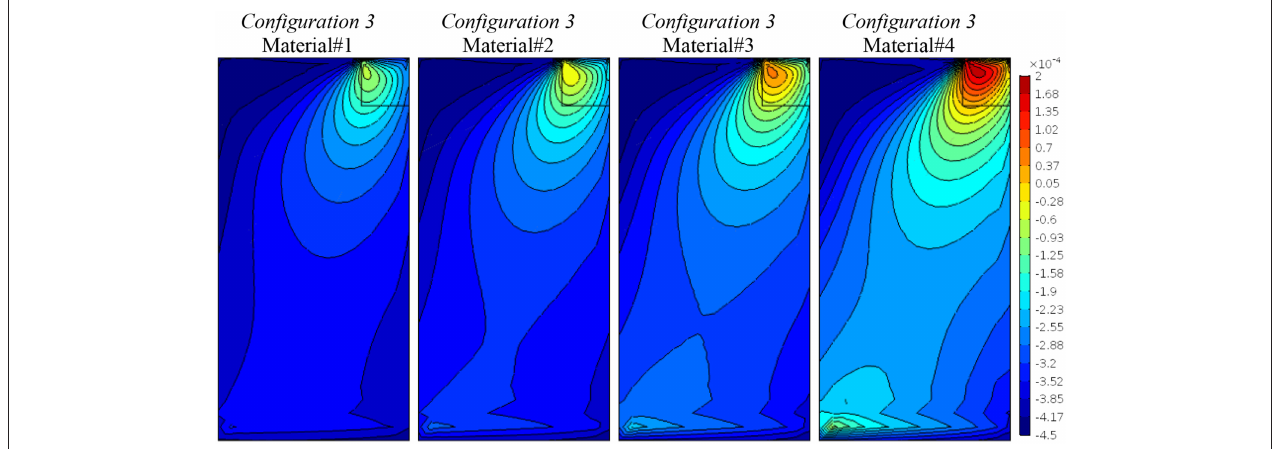
FIGURE 10 | Configuration 3, relative rotations, θ − φ , contour plots for four material cases (Material#1/Material#4 minimum/maximum anisotropy degree).